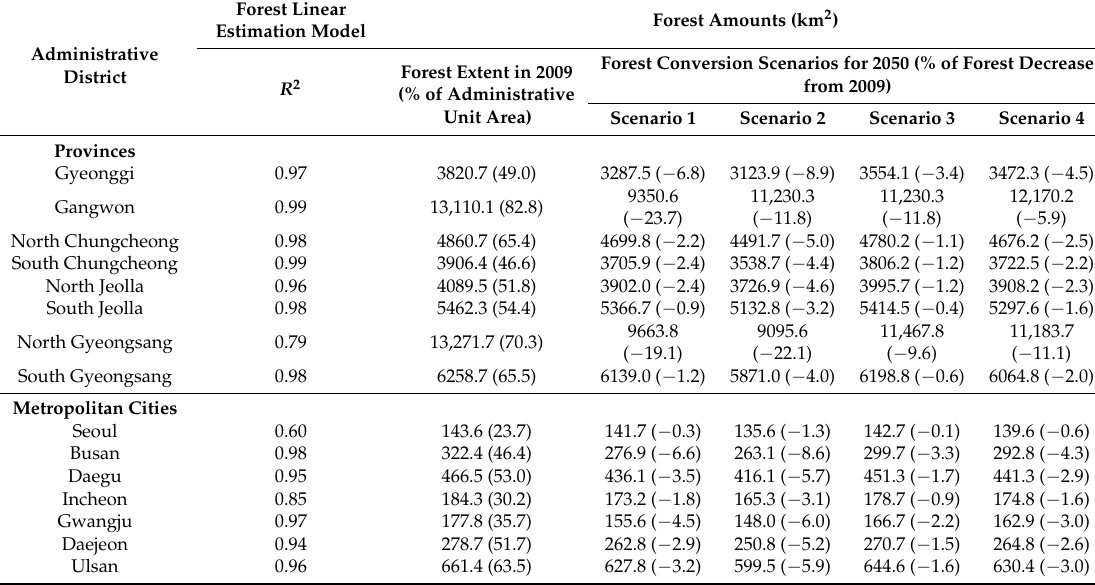
Table 1. Test of the forest amount linear model and forest amount estimation of each scenario for each district. The numbers in parentheses in the column of “Forest extent in 2009” represent the % of forest to total administrative area. The numbers in parentheses in the columns of “Forest conversion scenarios for 2050” represent the forest decrease ratios compared to the forest extent in 2009. Details about forest conversion scenarios are in the